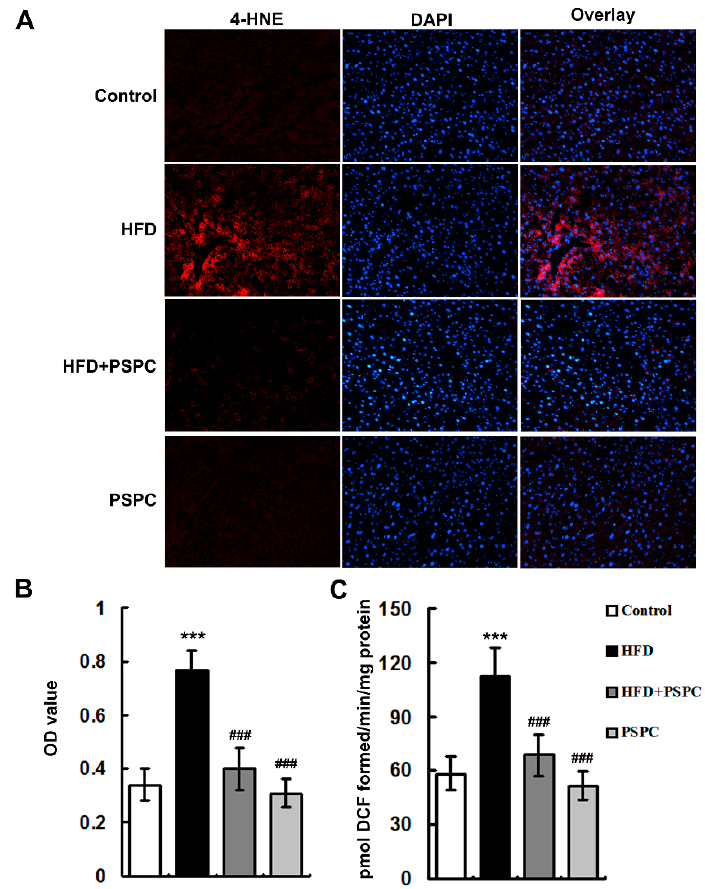
Figure 2. PSPC attenuates oxidative stress in HFD-treated mouse livers ( n = 5). ( A ) 4-HNE immunofluorescence staining, 200 × magnification; ( B ) 4-HNE fluorescence intensity was measured as the mean OD value; ( C ) ROS productions in mouse livers. All of the values are expressed as the mean ± SD. *** p < 0.001 vs. the control group; ### p < 0.001 vs. the HFD group.